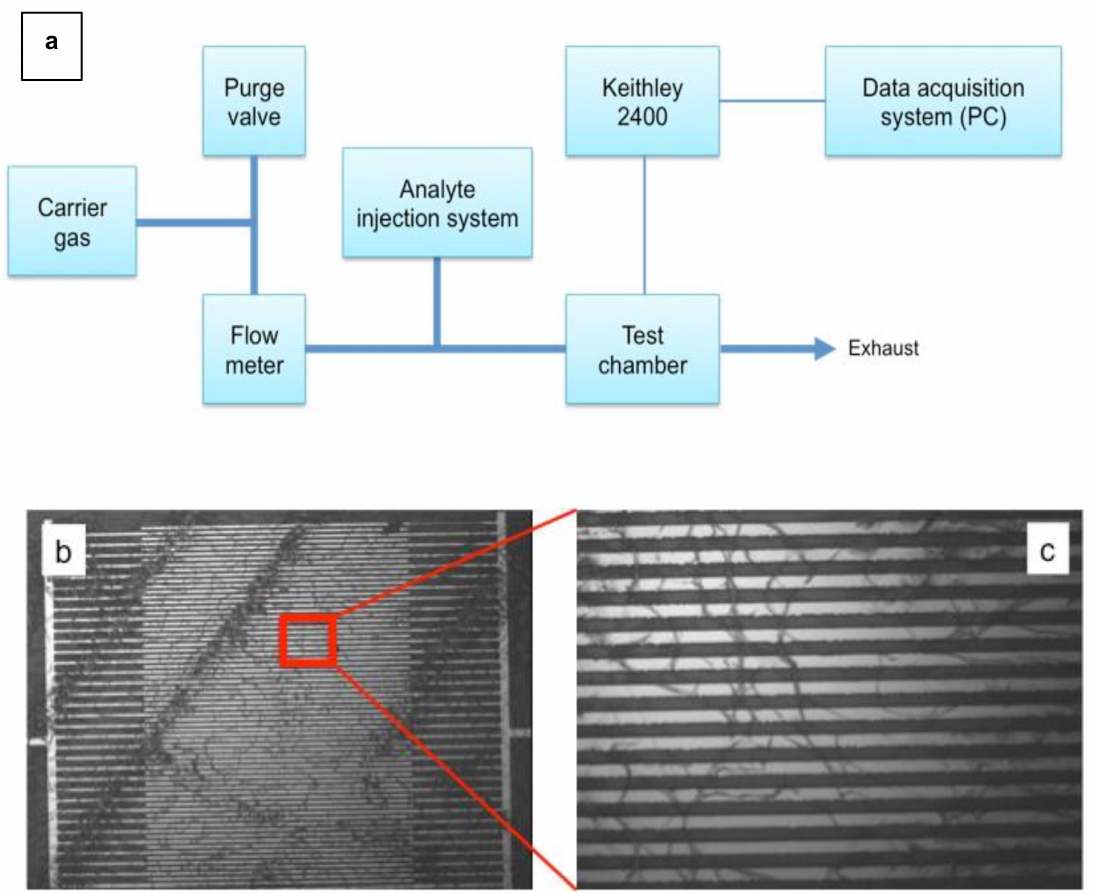
Figure 1. ( a ): Sketch of the gas sensing system used to test sensor devices. ( b , c ): micrographs at different magnfications of the tested P3HT NFs sensing element. The sizes of the micrographs are 580 × 435 µ m ( b ) and 116 × 86.6 µ m ( c